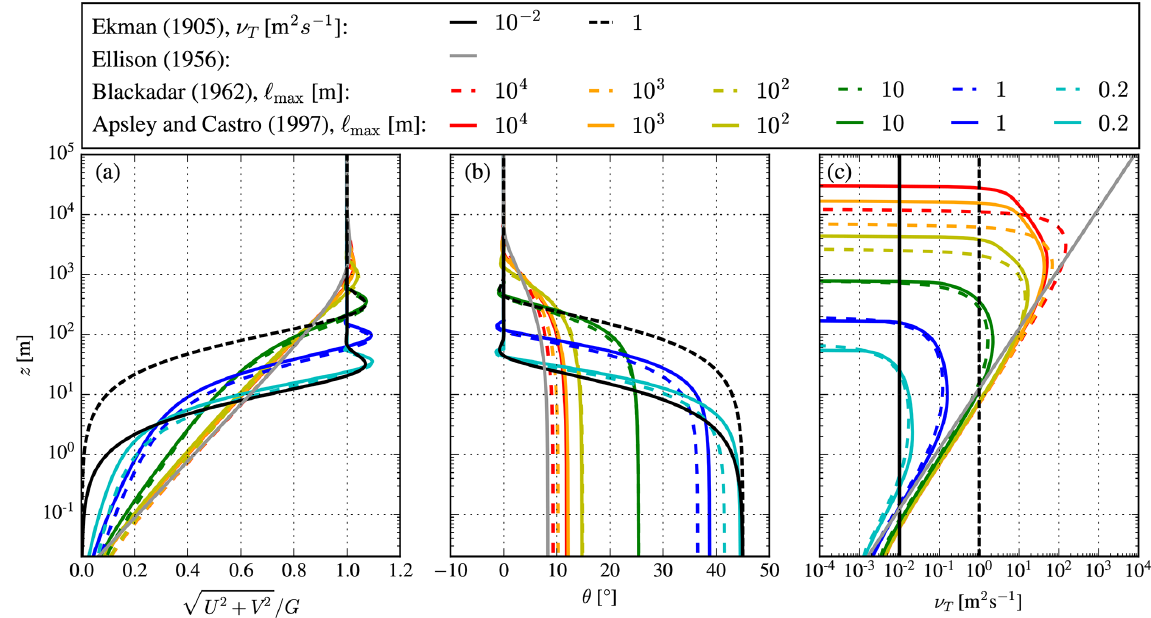
Figure 1. Comparison of analytic and numerical solutions of existing idealized ABL models using f c = 10 − 4 s − 1 , G = 10ms − 1 , and z 0 = 10 − 2 m for different model parameters. (a) Wind speed. (b) Wind direction. (c) Eddy viscosity. Table 1. Eddy viscosity closures for the idealized ABL. Eddy viscosity closure Solution Reference Constant Analytic Ekman (1905) Analytic Ellison (1956) Numerical Blackadar (1962) Apsley and Castro